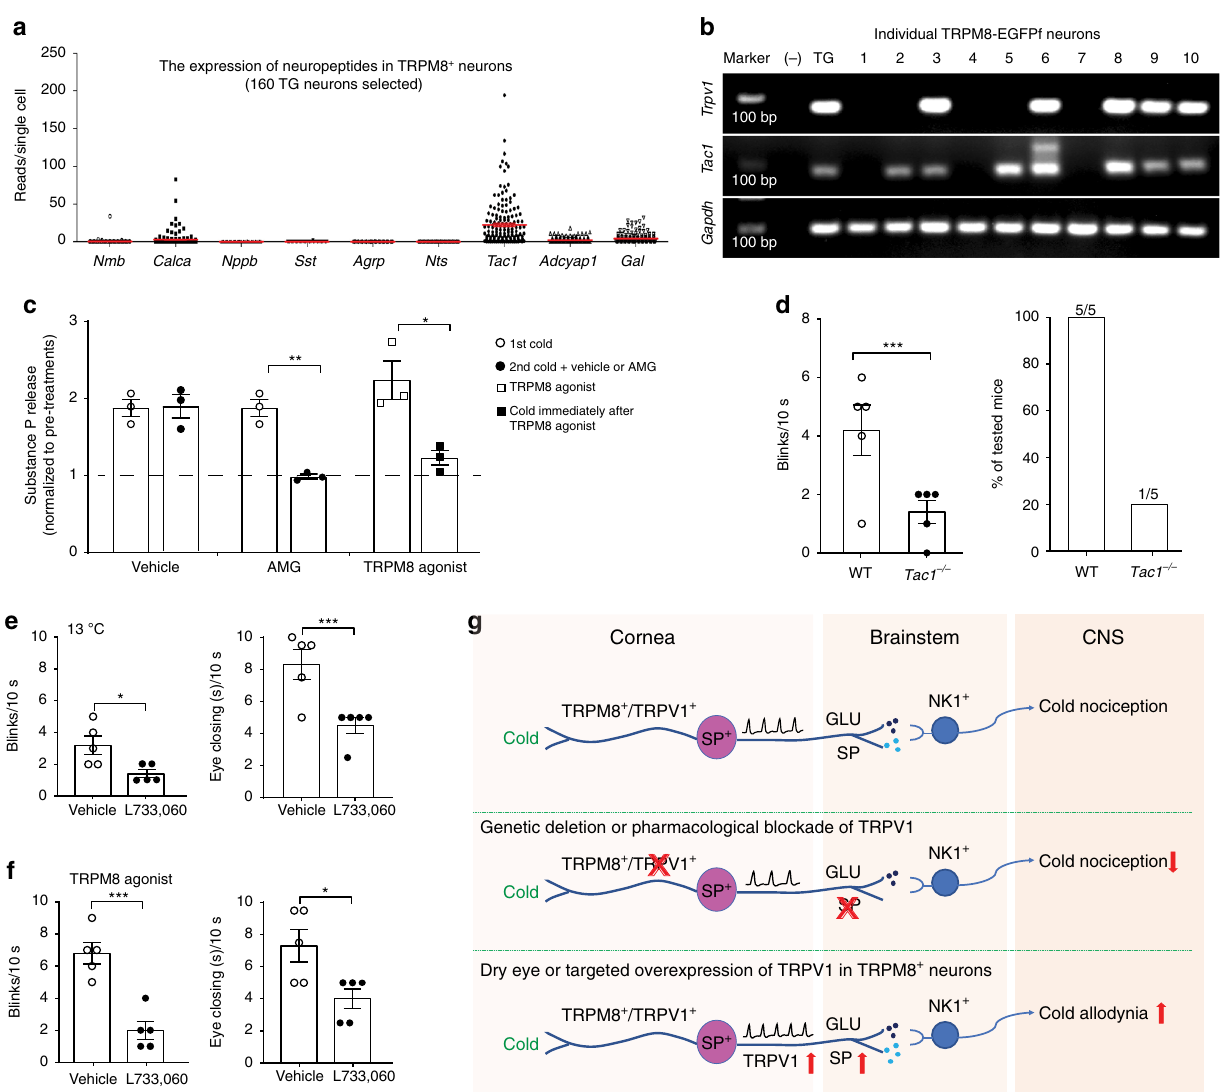
Fig. 7 Substance P release is required for corneal cold nociception. a The expression of neuropeptides in mouse TRPM8 + trigeminal ganglionic (TG) neurons based on single-cell RNA-seq data. Each dot represents a single TRPM8 + neuron. Full dataset and methods are available in Nguyen et al. 25 . b Single-cell RT-PCR using intron-spanning primers was performed on individual TRPM8-EGFPf sensory neurons that project to the cornea. All TRPM8 + / TRPV1 + neurons express substance P ( Tac1 ), while fewer TRPM8 + / TRPV1 - neurons express Tac1 . Negative control ( − ): No reverse transcription reaction on RNA sample from whole TG. Positive control (TG): cDNA from whole TG. c Cold treatments (bath temperature drops from 32 to15 °C) promote the release of substance P from dissociated trigeminal neurons, as revealed by ELISA assays. TRPV1 antagonist AMG9810 (AMG, 300 nM, 3 min pre- treatment before cold stimulations) suppressed the release of substance P, compared with the vehicle control (0.0006% DMSO). Cold-associated release of substance P was also suppressed by pre-desensitization of TRPM8 + neurons using TRPM8 agonist cryosim-3 (10 µ M). d Both the re fl ex blinking and eye closing responses to air fl ow at 13 °C were signi fi cantly reduced in Tac1 − / − mice, compared with WT controls ( n = 5 mice/group). e – f NK1 antagonist alleviates cold nociception. The re fl ex blinking and eye closing responses to cold (air fl ow at 13 °C) and cryosim-3 (0.1 nmol in 1 μ L) were signi fi cantly reduced 30 min after intracisternal injection of NK1 antagonist L733,060 hydrochloride (10 µ g in 5 µ L, n = 5 mice), compared with the vehicle-treated group (0.9% NaCl, n = 5 mice). g Model for neural pathways encoding corneal cold nociception and allodynia. SP: substance P. Data are expressed as mean ± s.e.m. Statistical analysis by two tailed Student ’ s t -test. * P < 0.05, ** P < 0.01, *** P < 0.001. Source data are provided as a Source Data fi le. P, which has been shown to mediate neurogenic in fl ammation 31,32 . TRPV1 is involved in cold allodynia associated with sensitive teeth Pharmacological blockade of TRPV1 decreases substance P release and fi bromyalgia affecting bones and muscles. In summary, our (Fig. 7c), and hence would attenuate associated in fl ammation and study sheds light on unexpected functions of TRPV1 in cold disease progression. Finally, the upregulation of TRPV1 in nociception and provides a common mechanism behind the cor- TRPM8 + neurons is suf fi cient to generate cold allodynia in both neal cold nociception and pathological cold allodynia, which opens corneal and non-corneal tissues, which offers a general mechanism an avenue for pain management. underlying cold allodynia associated with different conditions in different tissues. We have shown that TRPV1 is required for cold allodynia under in fl ammatory pain conditions in the skin (Sup- plementary Fig. 9). It would be interesting to further study whether NATURE COMMUNICATIONS| (2019) 10:5678